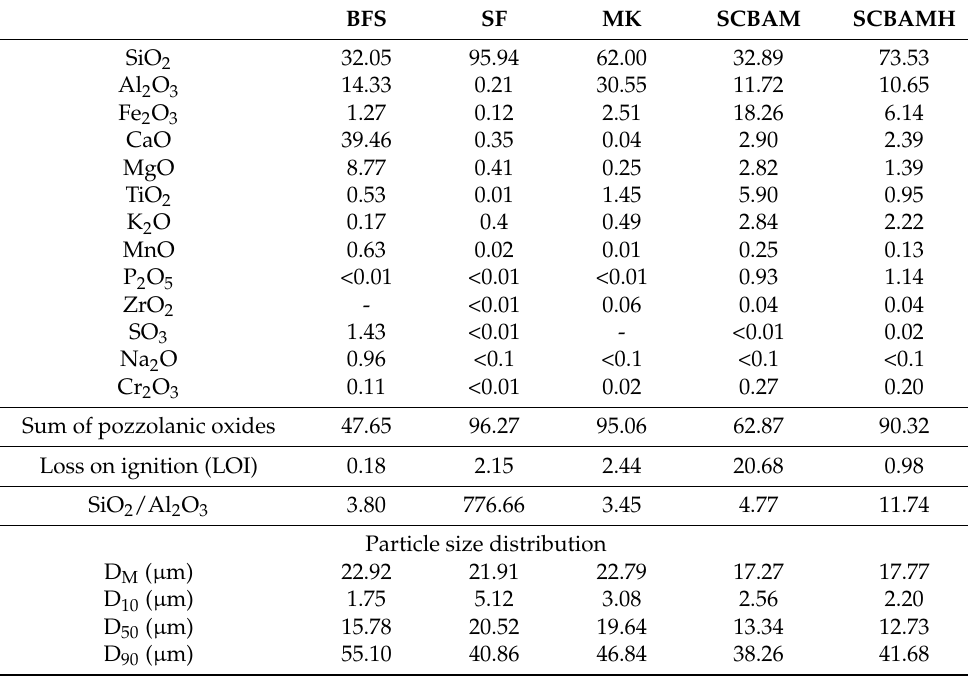
Table 1. Chemical composition by XRF